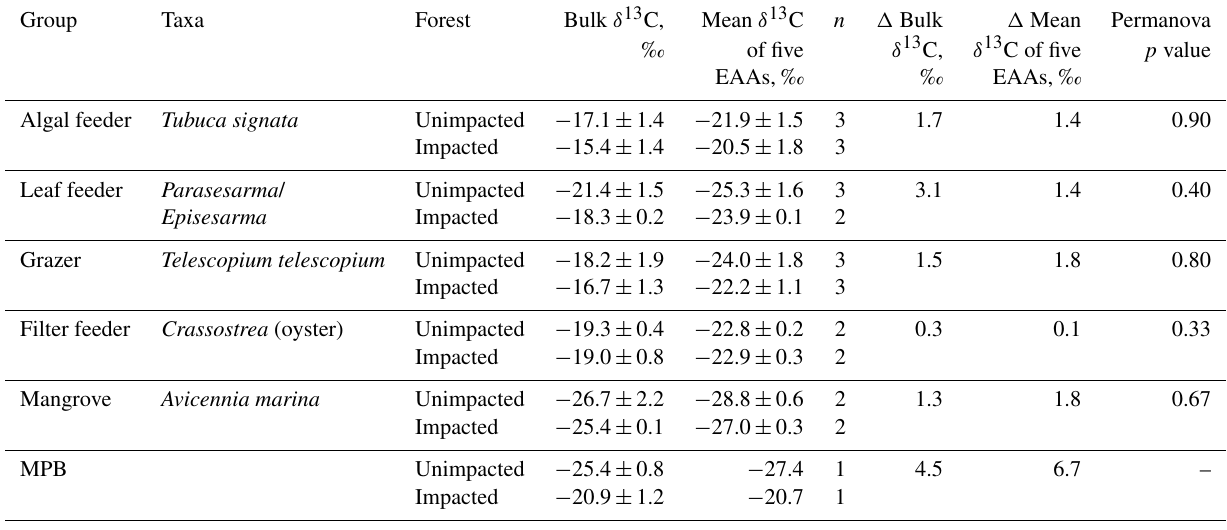
Table 4. Bulk δ 13 C values, mean δ 13 C values of five EAAs (‰ ) and differences ( (cid:49) , ‰) between the two forests in 2017, 20 months after the dieback (mean ± SD).